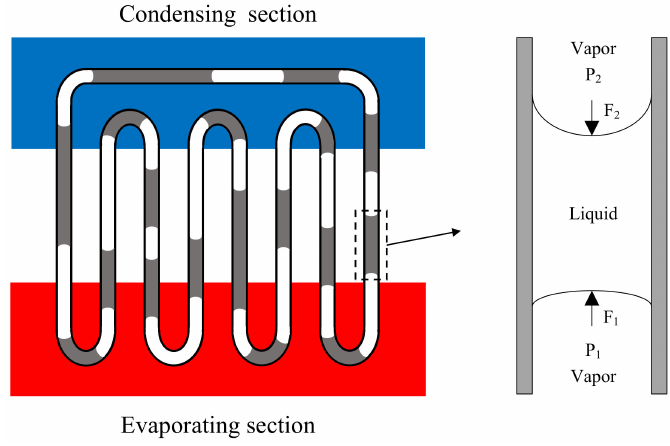
Figure 2. Basic structure of typical pulsating heat pipe